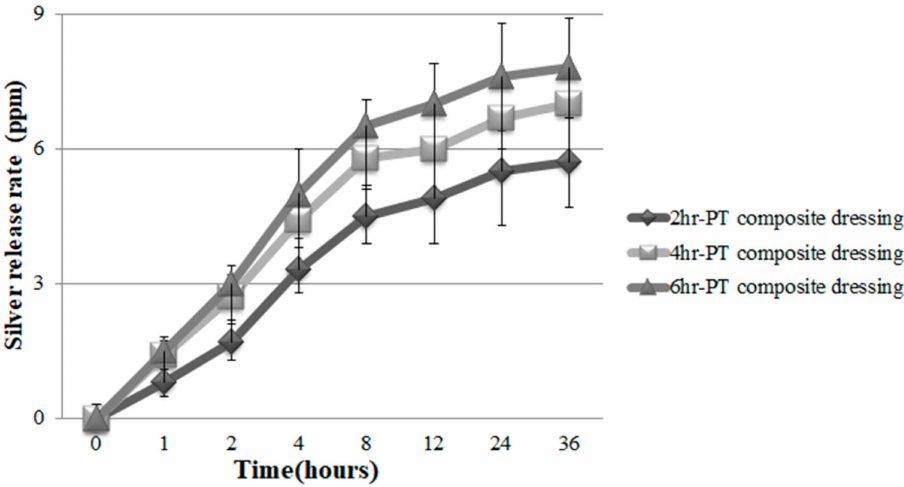
Figure 13. Silver release rate of PT nonwoven dressing with various reaction time.